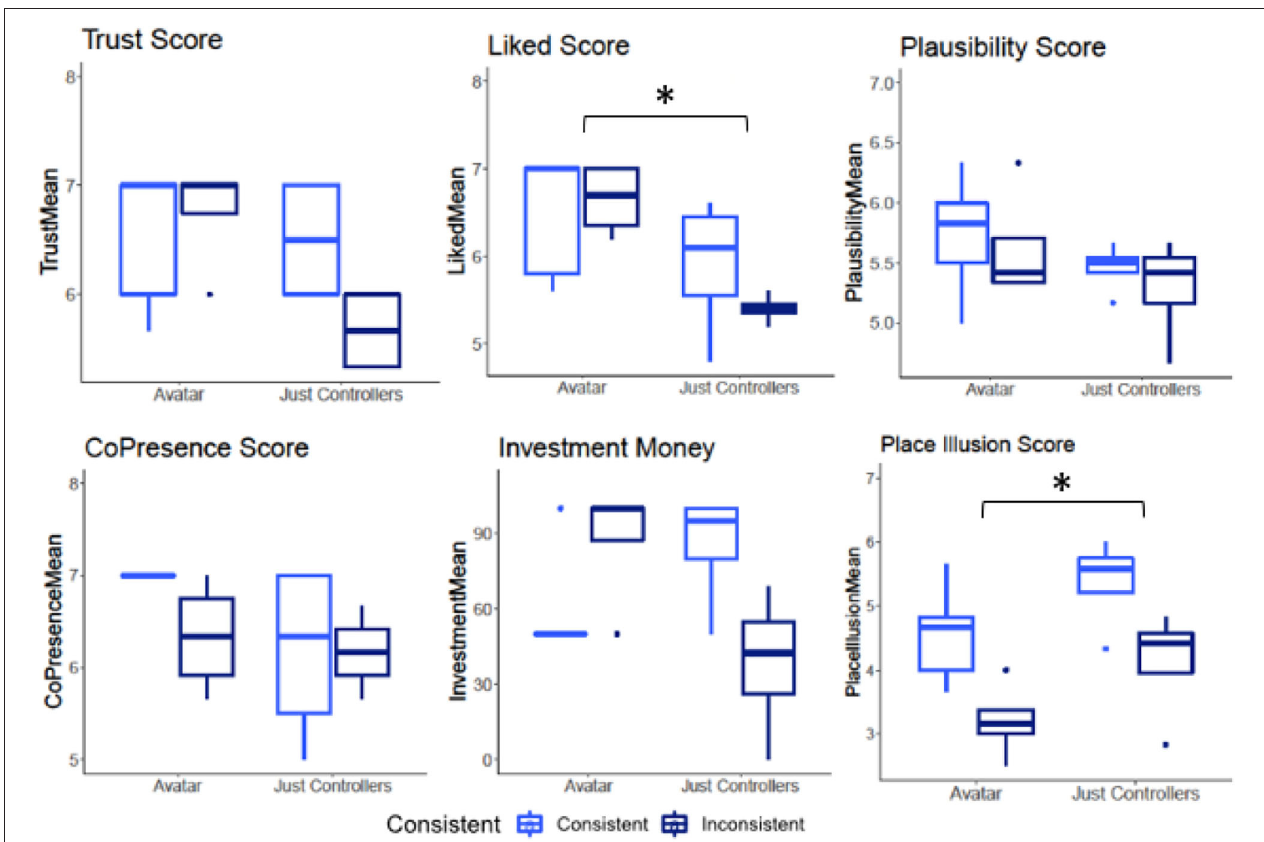
FIGURE 4 | Study 1: boxplots of the social presence questionnaire components and investment game. * p < 0.05.